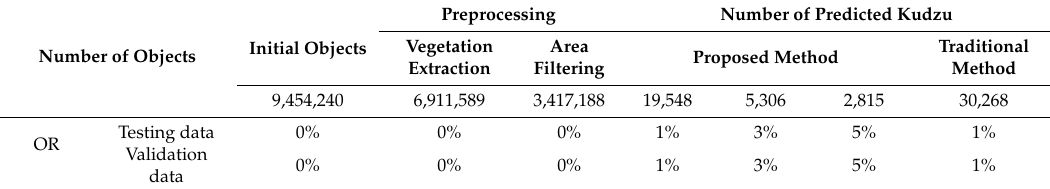
Table 3. Number of objects after each procedure and the corresponding omission rate (OR) of kudzu based on the testing and validation